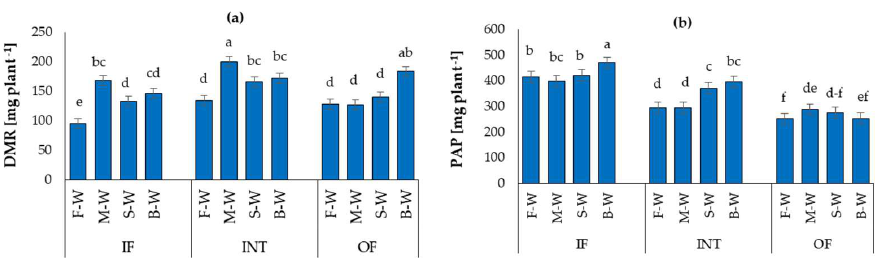
Figure 3. Effects of interaction between three farm management practices (intensive, IF; organic, OF; and integrated, INT) and four crop rotation systems (F-W, fallow-wheat; M-W, maize-wheat; S-W, sesame-wheat, and B-W, mung bean-wheat) on ( a ) DMR (dry matter remobilisation), and ( b ) PAP (post-anthesis dry matter photosynthesis). Means were compared by Duncan’s test, and different letters above each bar indicate a significant difference at p ≤ 0.05.